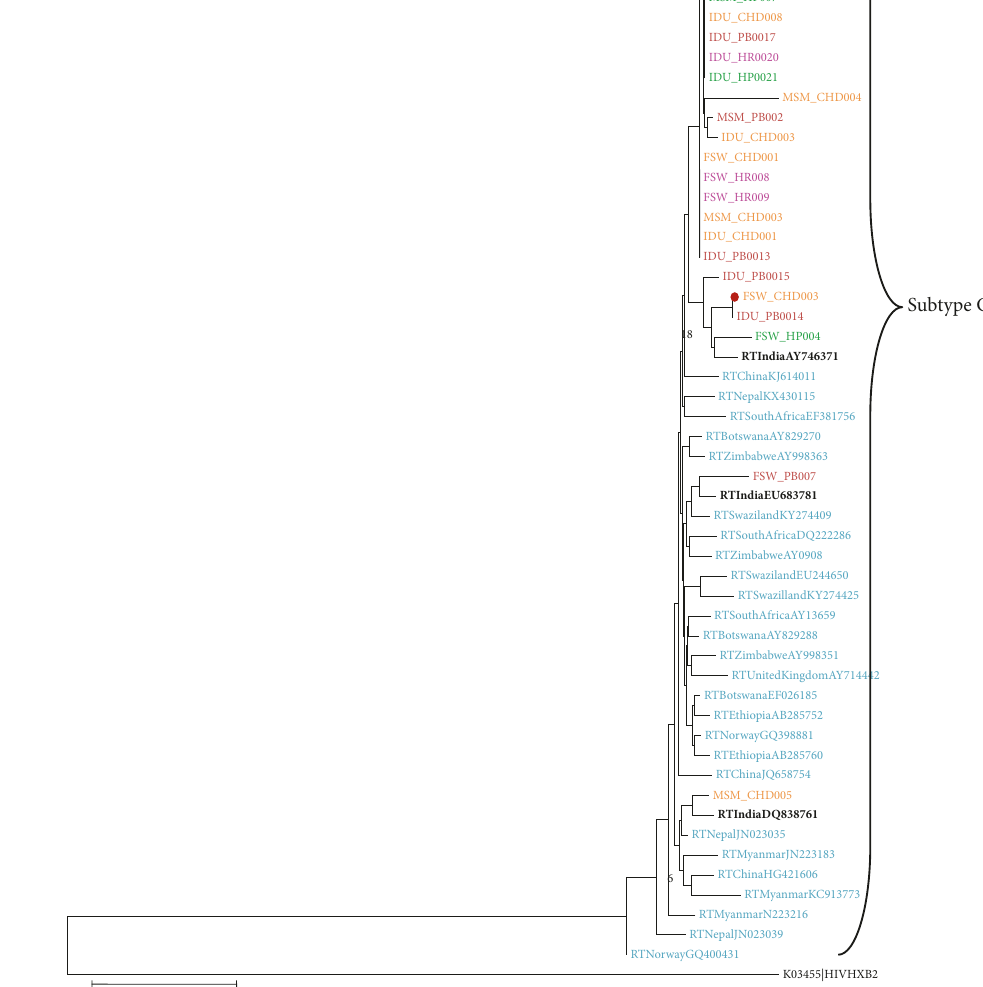
Figure 1: Phylogenetic relationship based on pol gene (reverse transcriptase 1–268 codon) sequences. Sequences are from Punjab shown in (dark red color), Haryana (pink color), Chandigarh (Brick red color), and Himachal Pradesh (Green color). Drug resistance isolates highlighted in different symbols, i.e., (cid:2) : L74V, ‰ : K219N, ◻ : Y181C, (cid:3) : K219R. Global HIV-1 subtype C reference sequences (shown in blue & black color) and K obtained from Los Alamos HIV Sequence Database. Both Y181C isolates (IDU CHD004 and IDU CHD009) are IDUs; they are unique and not showing any clustering or